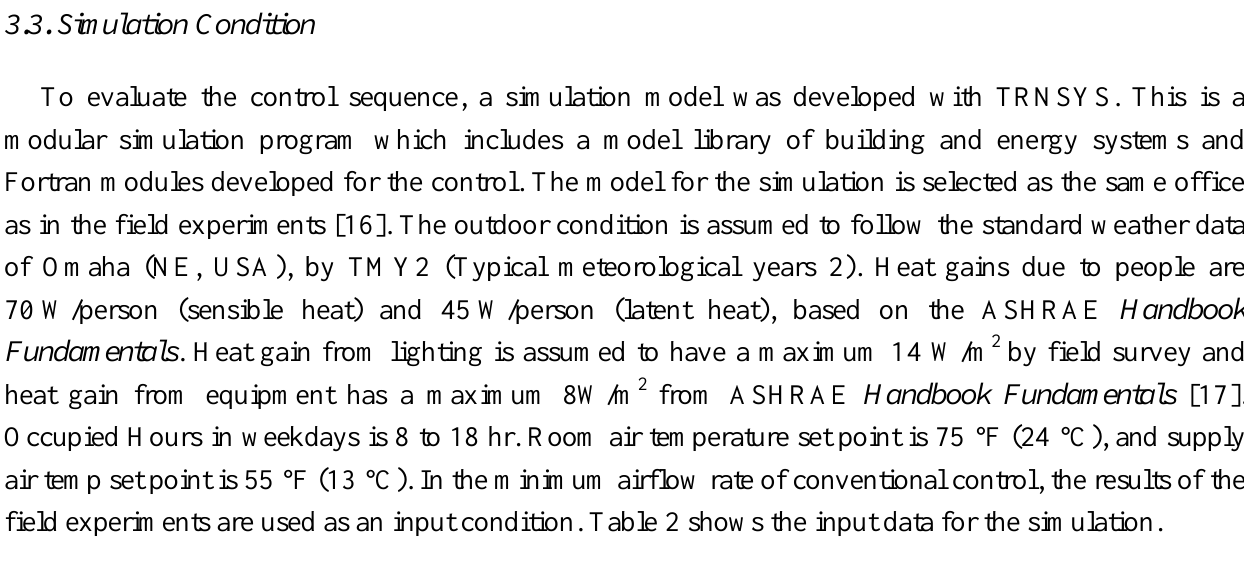
Table 2. Input data for the